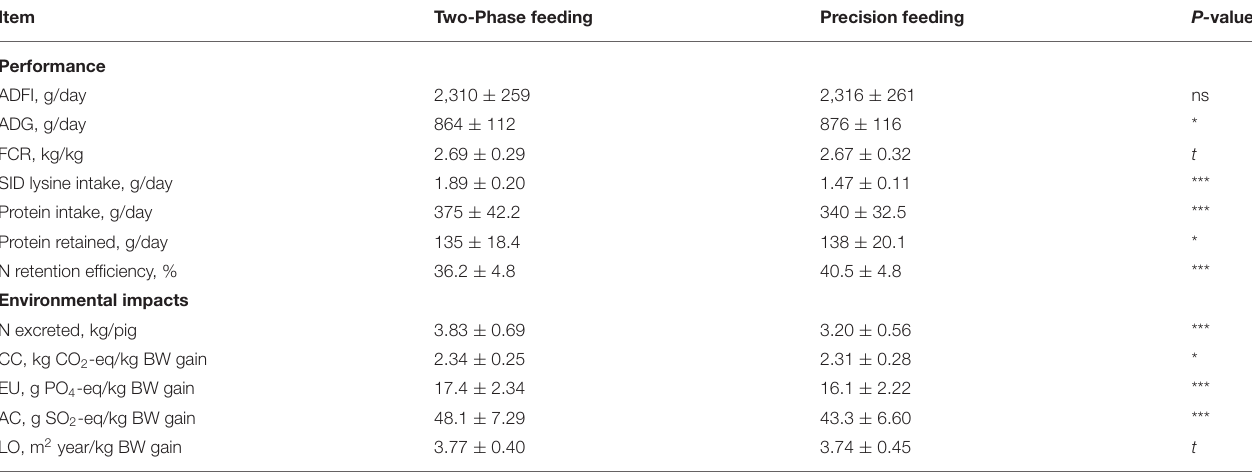
TABLE 1 | Effect of feeding strategy on pig performance, nitrogen excretion, and environmental impacts measured by life cycle assessment ( n = 1,000 pigs). Item Two-Phase feeding Precision feeding P- value a